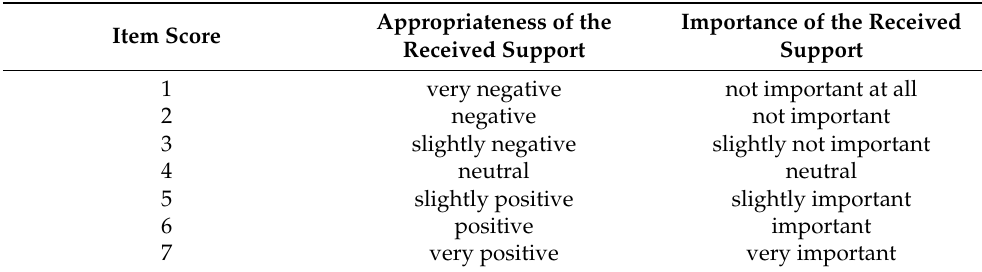
Table 3. Scoring table for the pre-test questionnaire for the factors with their semantic meaning and the corresponding value of 1–7 in the Likert scale system. Item